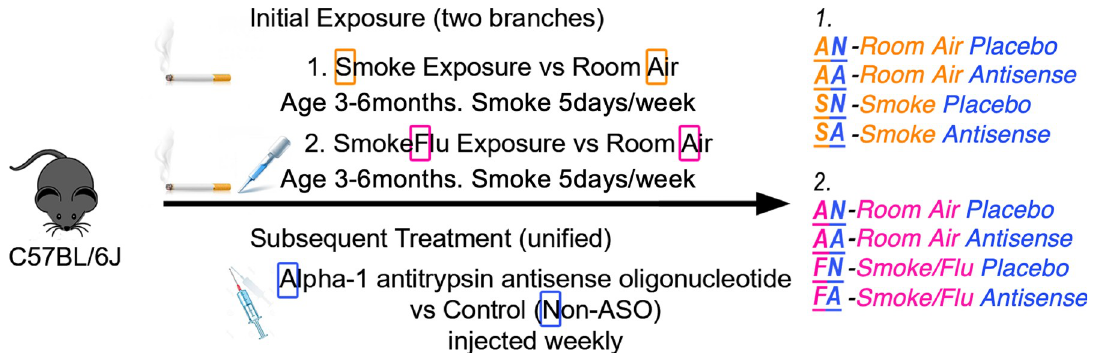
Fig 1. Experimental design. Alpha-1 antitrypsin antisense oligonucleotide treatment was tested in two lung injury models, smoke exposure for chronic obstructive pulmonary disease (COPD) and additional influenza infection for COPD exacerbation. Mice were randomly divided into 4 groups, first letter indicating the exposure or lung injury model (A for room air or S for smoke exposure; A for room air or F for smoke-flu exposure), second letter representing the treatment with or without ASO (A for AAT ASO or N for non- AAT control